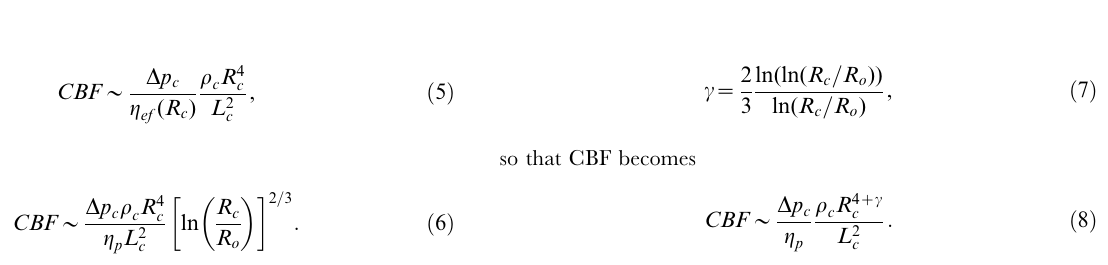
Figure 2. Scaling of cerebral blood flow CBF in the subcortical gray matter. (A) Hippocampus: y ~{ 0 : 135 x z 1 : 89 ( R 2 ~ 0 : 90 , p ~ 0 : 049 ), slope CI=( 2 0.271,0.000). (B) Thalamus: y ~{ 0 : 167 x z 2 : 02 ( R 2 ~ 0 : 83 , p ~ 0 : 011 ), slope CI=( 2 0.272, 2 0.062). (C) Cerebellum: y ~{ 0 : 177 x z 2 : 03 ( R 2 ~ 0 : 88 , p ~ 0 : 002 ), slope CI=( 2 0.252, 2 0.102).